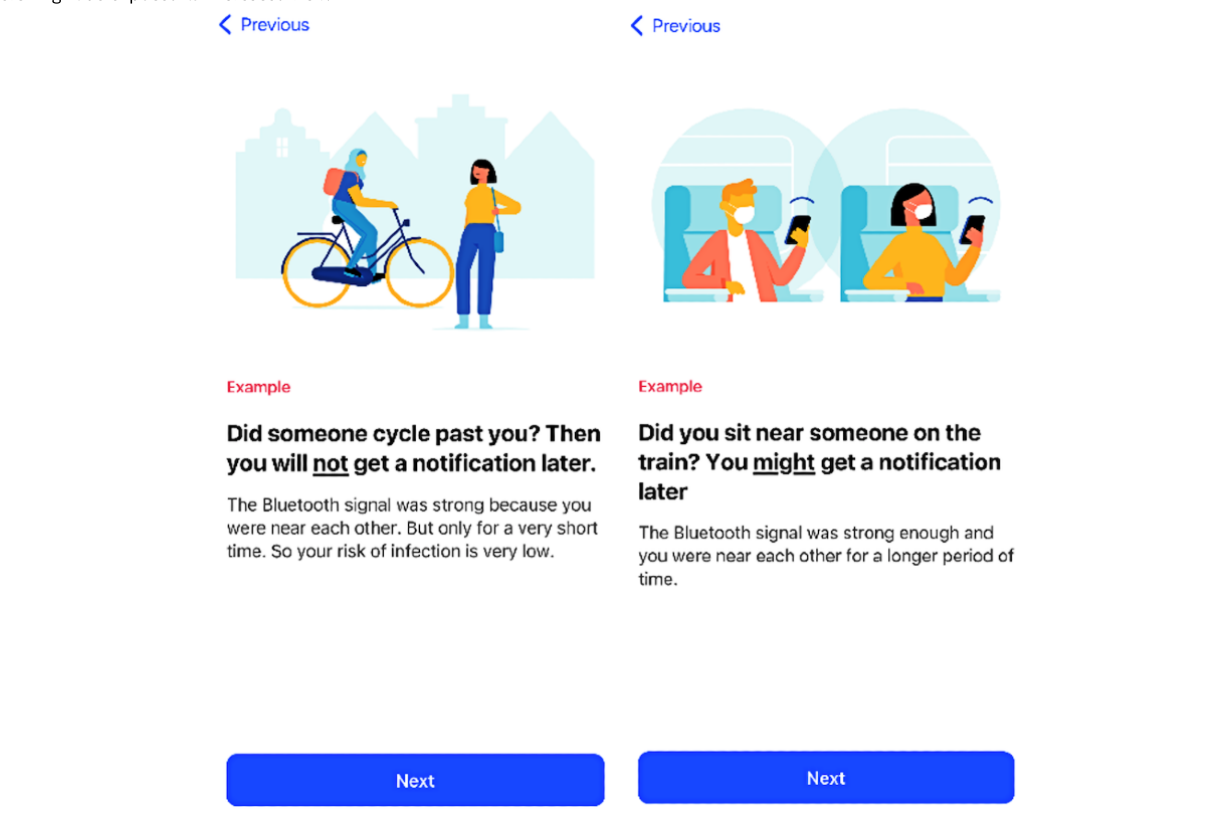
Figure 3. App screenshots viewed during onboarding: (left) an example of when users are not exposed to increased risk and (right) an example of when users might be exposed to increased